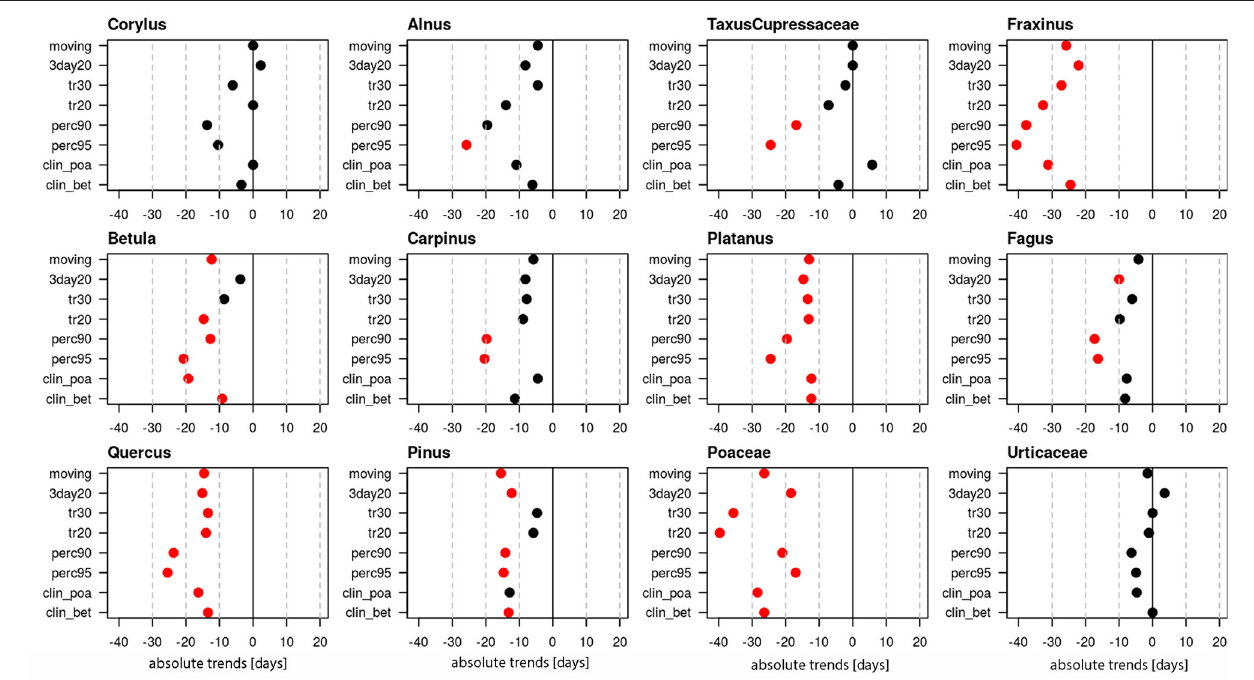
FIGURE 3 | Absolute trends [days] for the 50-year period 1969–2018 of the end dates of the pollen season with eight different pollen season definitions. Red points show significant trends ( p -value ≤ 0.05), black points show non-significant trends.